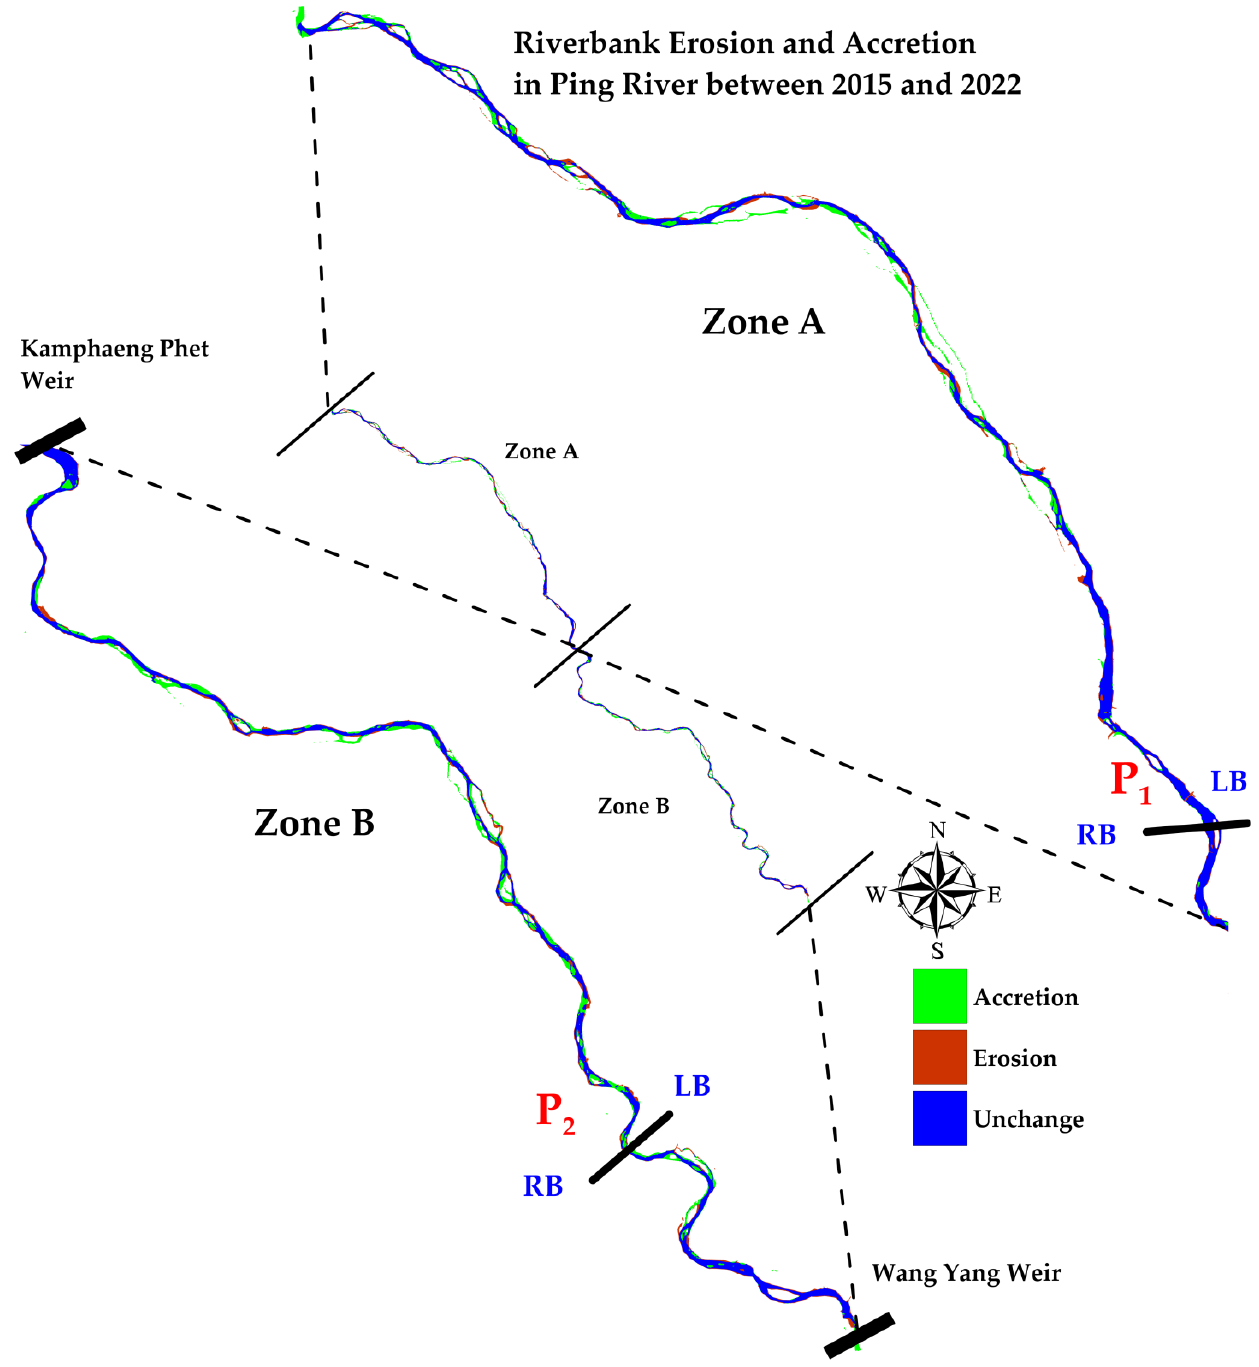
Figure 12. Riverbank erosion (red) and accretion (green) along the Ping River between 2015 and 2022; Zone A is the upstream reach and zone B is the downstream reach. RB (LB) is the right (left) bank.